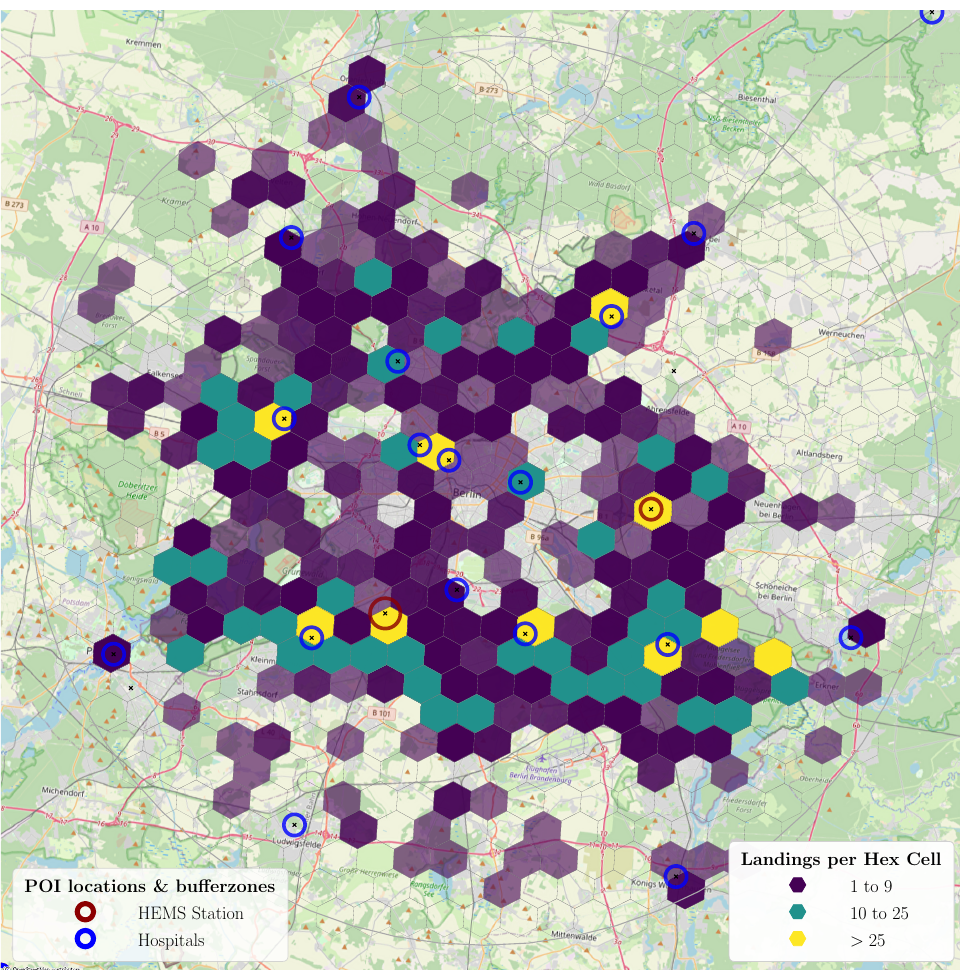
1 Figure 1. Map of the urban area of Berlin with known helipad locations (POIs) and color-coded